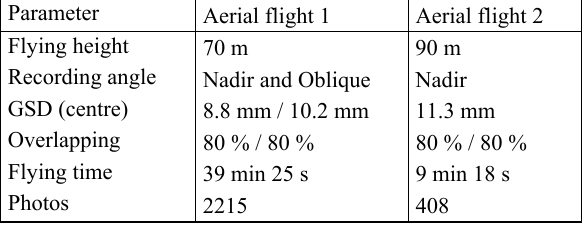
Table 1 . Aerial flights with the Zenmuse P1 camera.